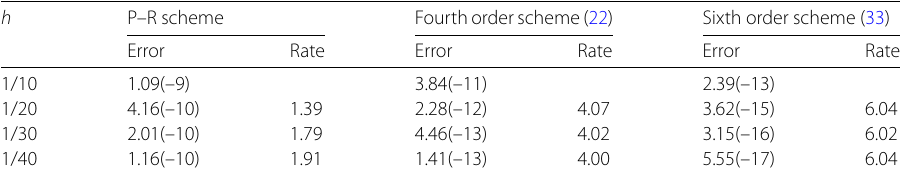
Table 1 L 2 -norm error and convergence rate for Problem 1 with h = τ at T = 1